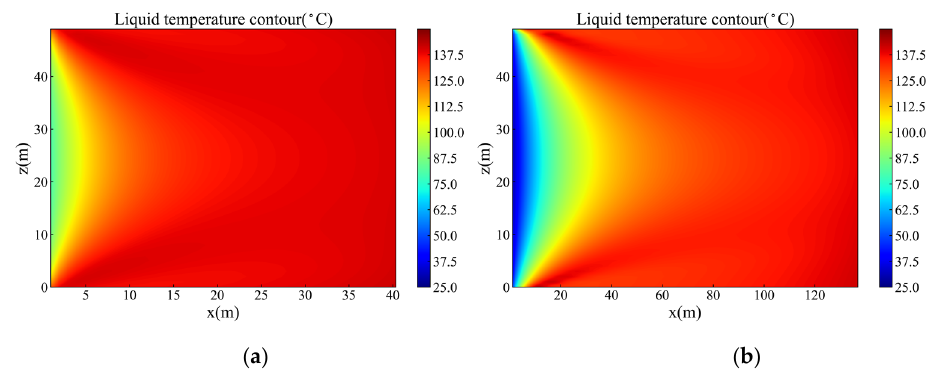
Figure 12. Thermal maps of the fluid in the fracture at 10 and 90 min. ( a ) 10 min, ( b ) 90 min.